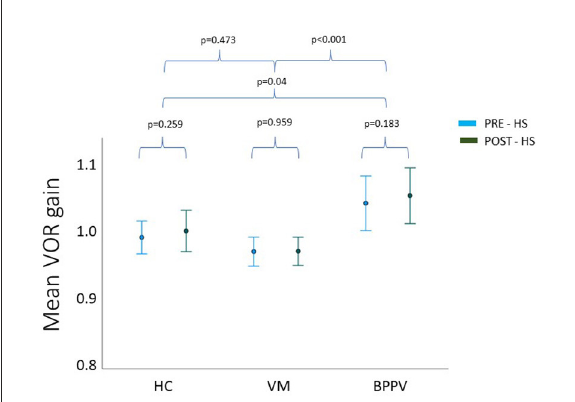
FIGURE2 Mean pre and post headshake VOR gain for each group. HC, healthy controls; BPPV, benign paroxysmal positional vertigo; VM, vestibular